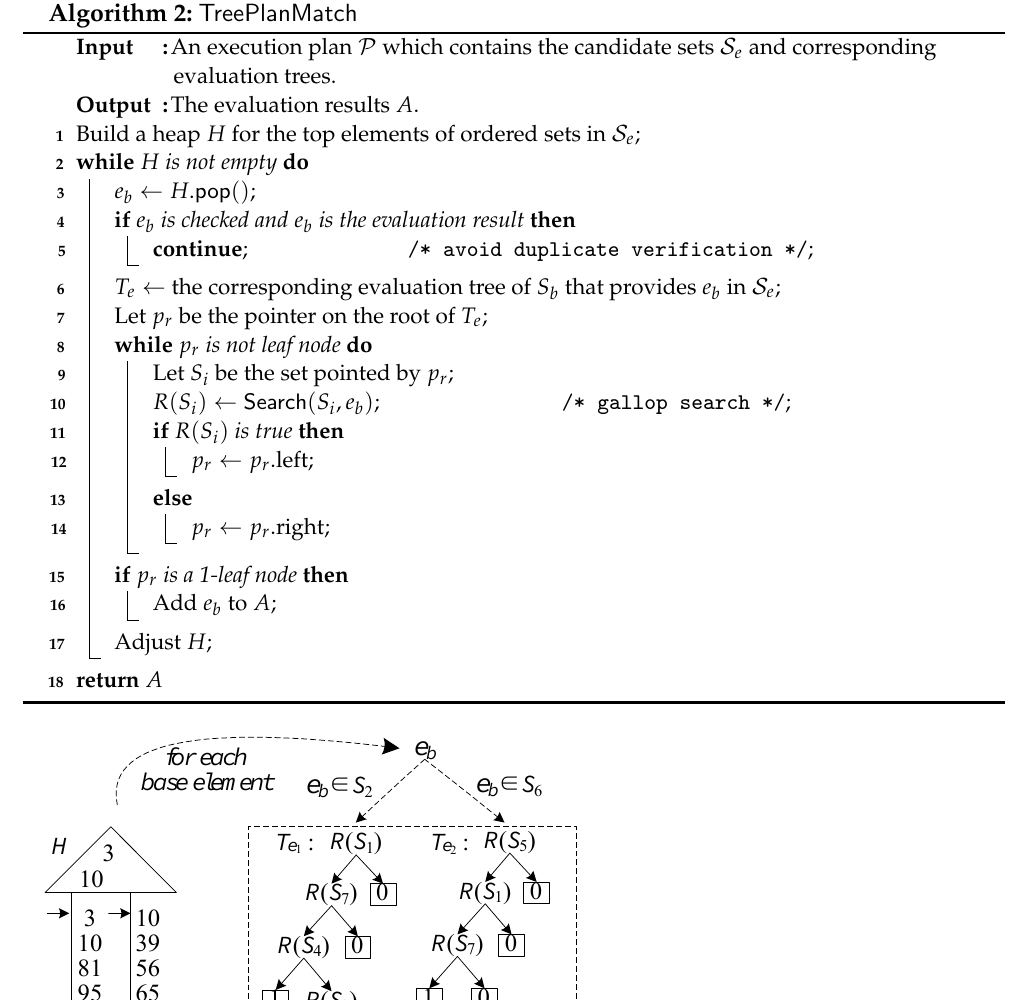
Algorithm 2: TreePlanMatch